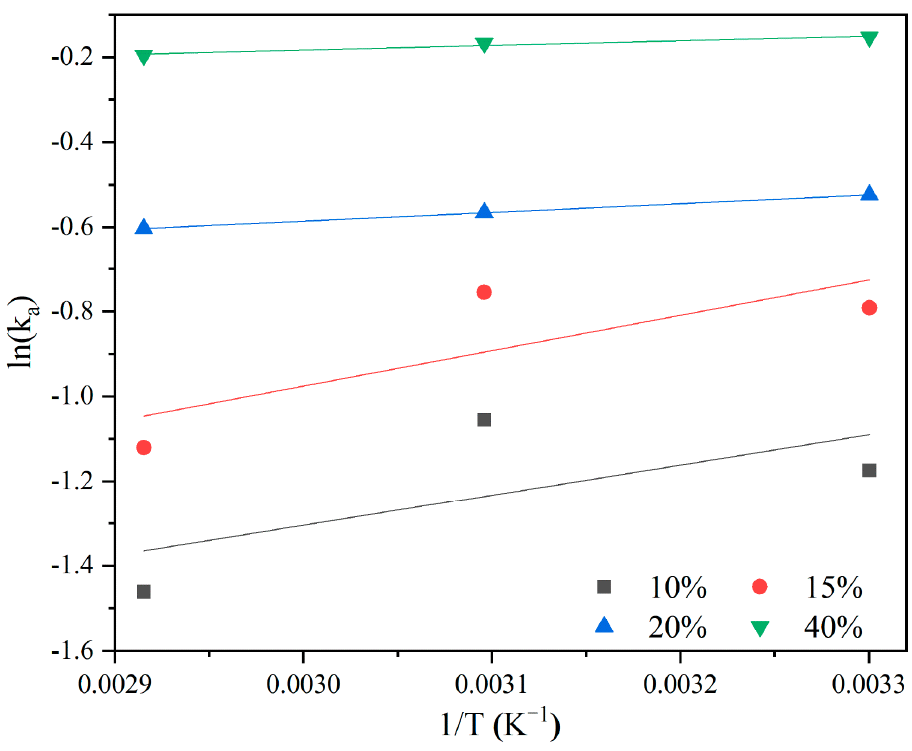
Figure 8. Arrhenius plots for the kinetic constant k a obtained for the Avrami model. Table 6. Related parameters calculated from CO 2 adsorption isotherms fitted to the Arrhenius Equation. CO 2 Concentration